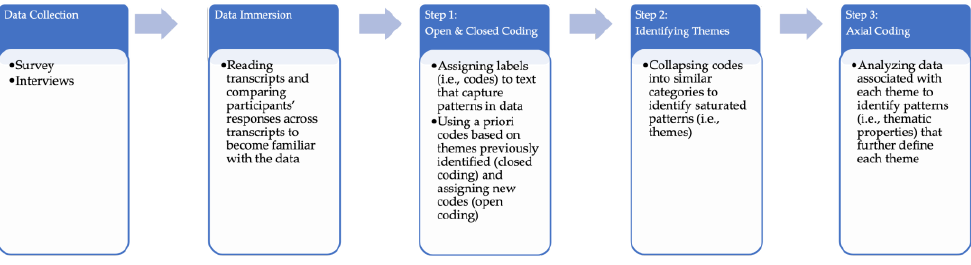
Figure 1. Thematic analytical steps of CMM .